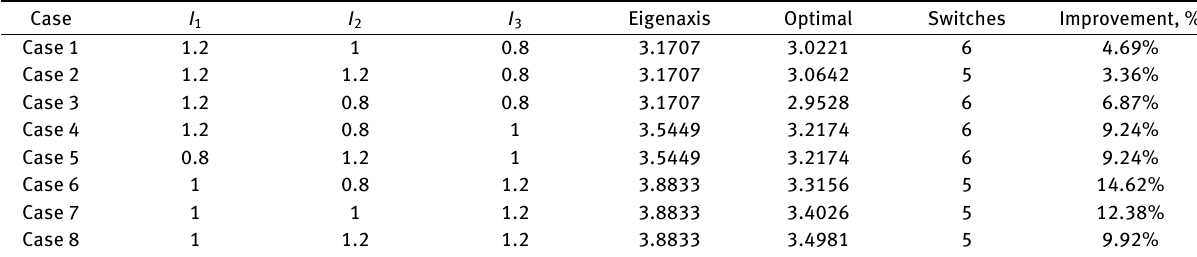
Figure 2. Block diagram of solving this problem using the hp-adaptive pseudospectral method. Table 1. The optimal solutions for some general